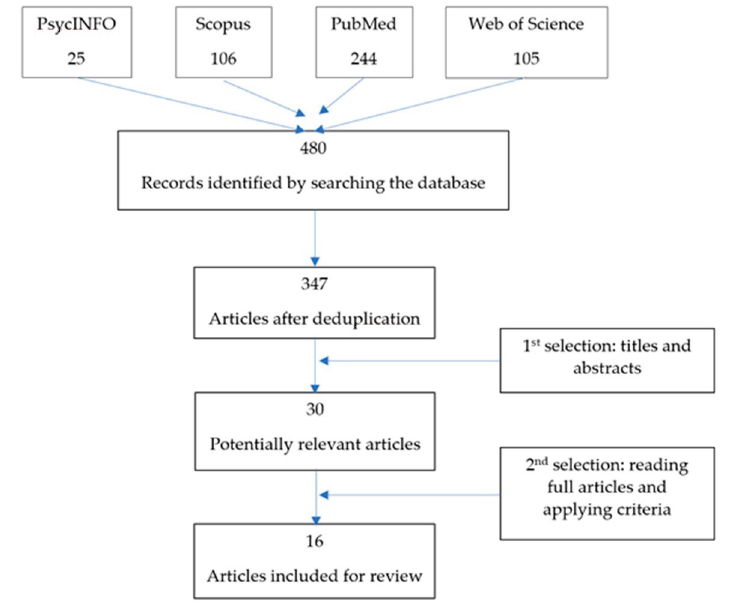
Figure 1. Flow diagram for article selection.